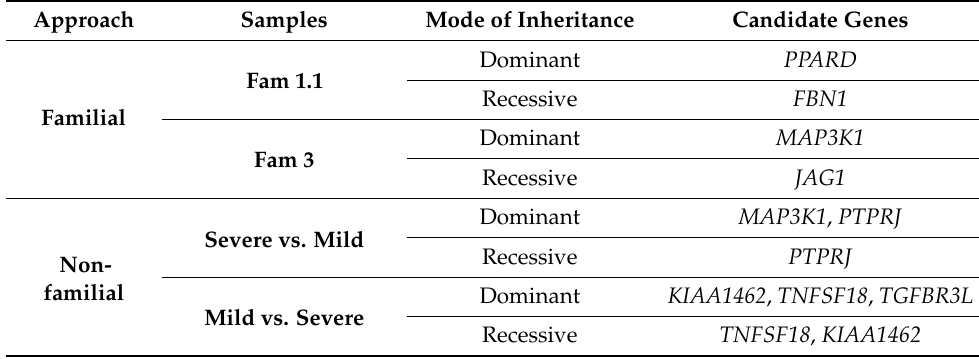
Table 3. Candidate modifying genes identified under different VAAST analysis